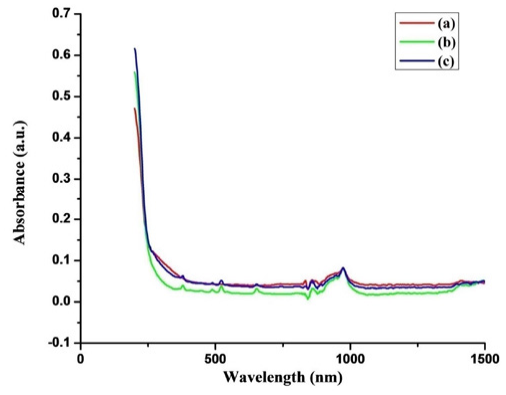
Fig. 6 Absorption spectra obtained for (a) 20%Yb 3+ /2%Er 3+ :NaLuF 4 and 20%Yb 3+ /2%Er 3+ doped NaLuF 4 nanocrystals with different Gd 3+ contents: (b) 20% (c) 45%